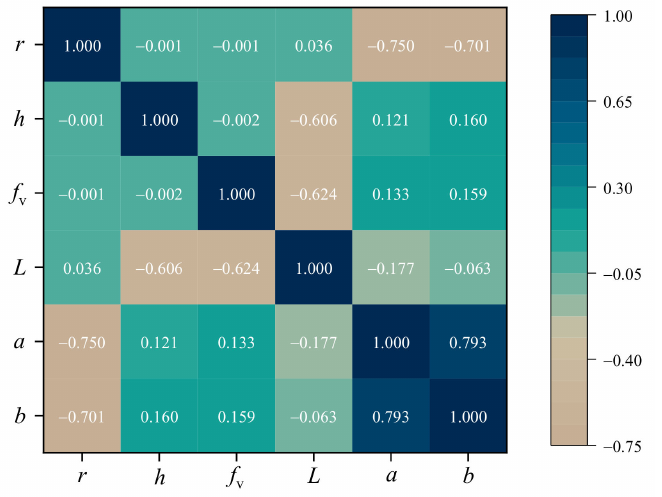
Figure 6. The heat map of the Pearson correlation coefficient matrix within the input geometric parameters ( r , f v , h ) and output color properties ( L , a , b